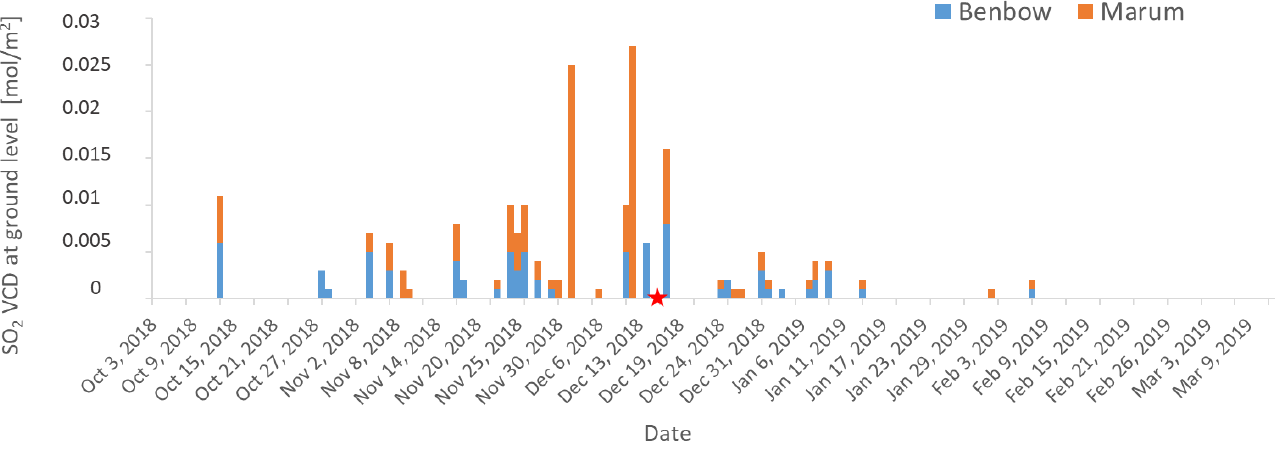
Figure 7. Time series of the SO 2 VCD (Vertical Column Density) at the ground level in units of mol/m 2 retrieved from Sentinel-5P TROPOMI data (at the spatial resolution of 3.5 km × 7 km) from October 2018 – March 2019. Plot displays the average VCD value retrieved over the Marum and Benbow craters; the start of the eruption is marked in red.